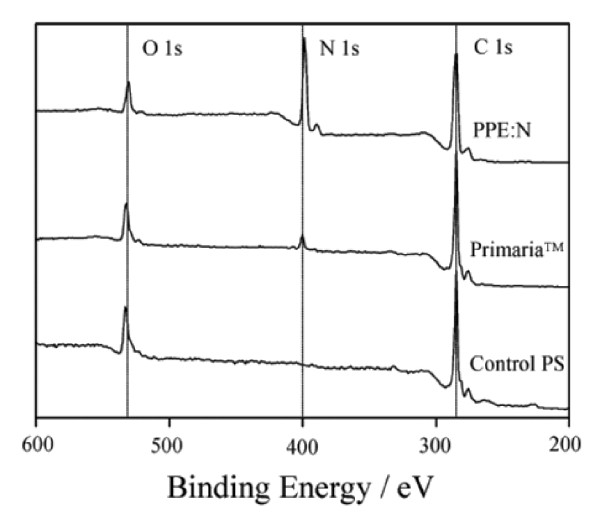
XPS broad-scan spectra of commercial polystyrene and Primaria® culture dishes, and of PPE:N surfaces.